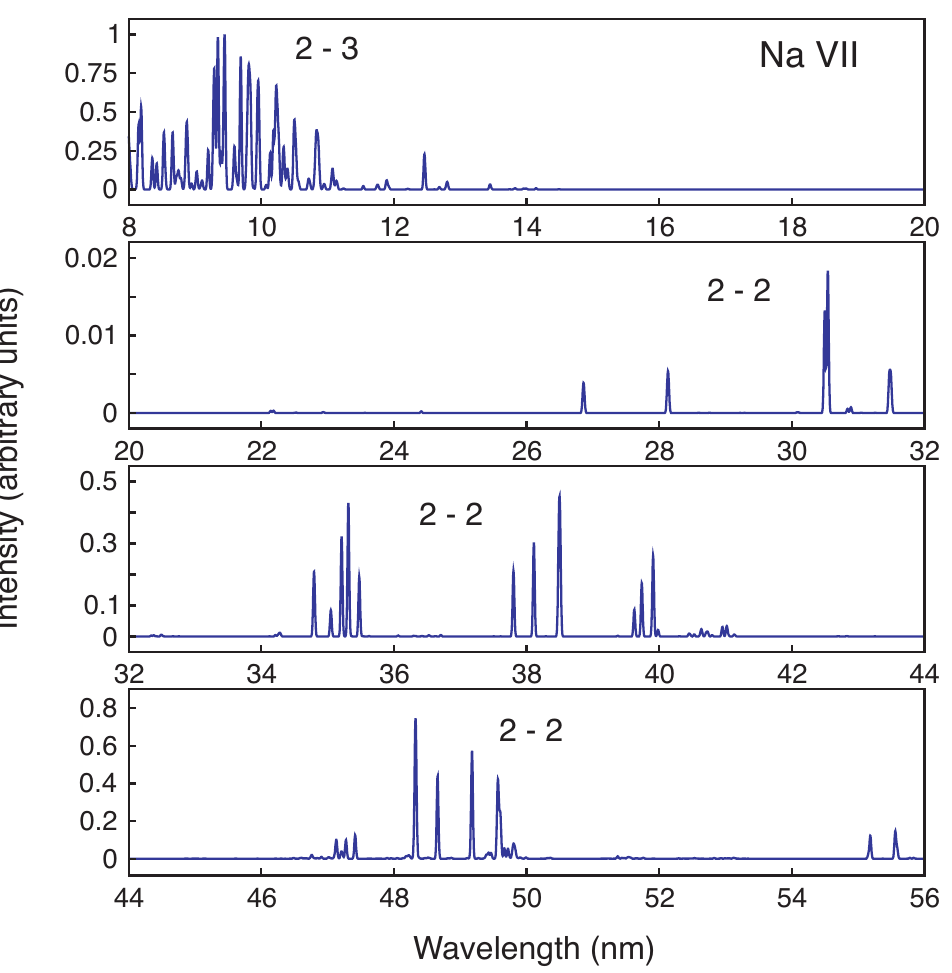
Figure 1. Synthetic Na VII spectrum containing transitions between 8 and 56 nm from the present calculation. The short wavelength range has predominantly n = 2 − 3 transitions, whereas the n = 2 − 2 transitions spread over the range 30 to 80 nm. See the text for